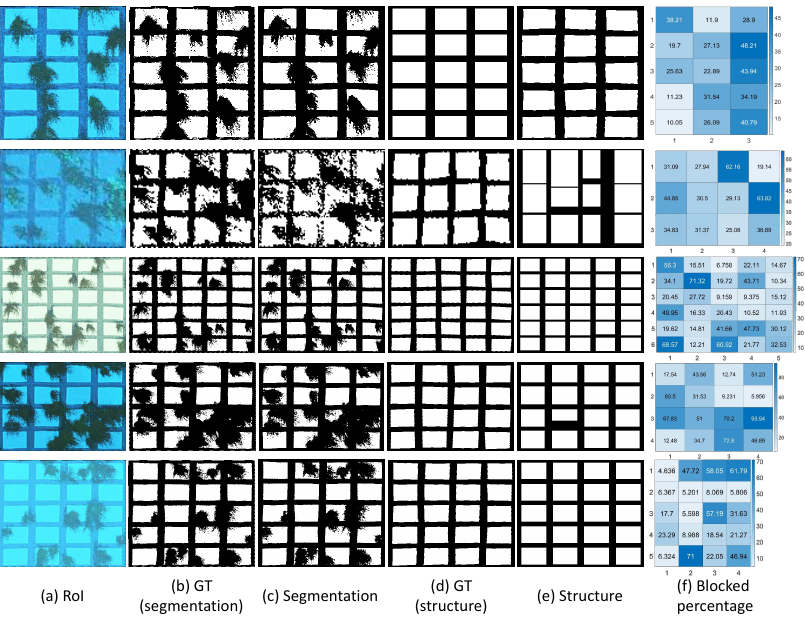
Figure 13. Qualitativeevaluationonvirtualscenes. ( a )RoI;( b )segmentationground-truth; ( c )segmentation results; ( d ) structure (rectangle) ground-truth; ( e ) structure results; and ( f ) blocked percentage